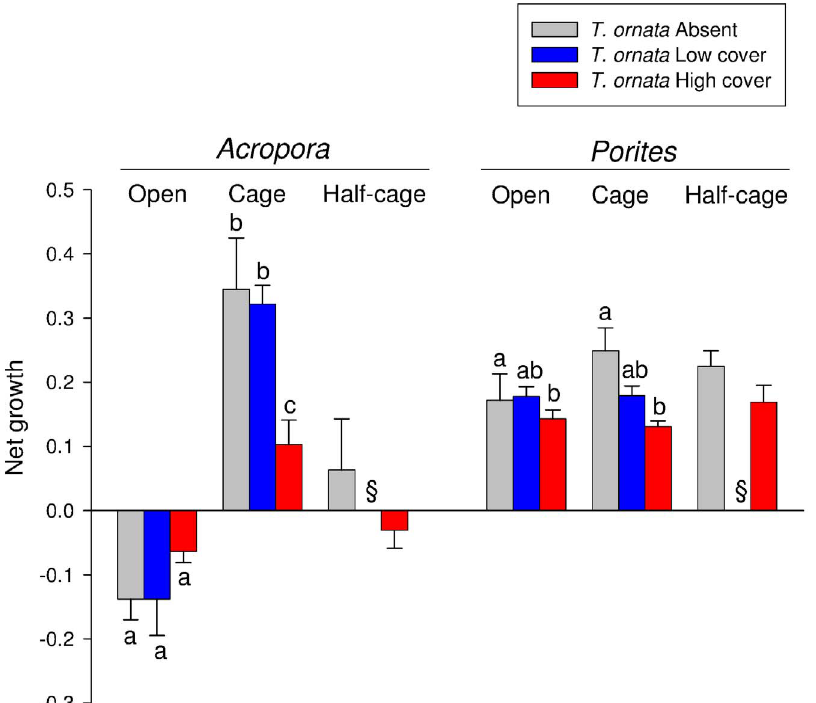
Figure 3. Net growth (mean + 1SE) of Acroporapulchra and Poritesrus exposed to different combinations of consumers (open versus caged versus half-cages) and cover of Turbinariaornata (absent versus medium cover versus high cover). Letters above bars illustrate the outcome of SNK (Student-Newman-Keuls) tests for the interaction Consumers 6 T. ornata ; different letters indicate significant differences at P , 0.05. Data are averages across slabs; n =12. 1 = no data (the combination T. ornata medium cover and half cage was not included in the experiment design).